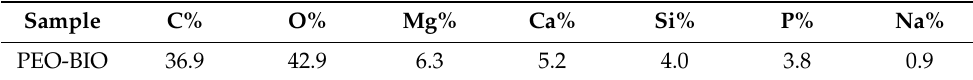
Figure 4. XPS survey scan ( a ) and XPS high-resolution single peak spectra of the Ca2p region ( b ), the P2p region ( c ) and the Si2p region ( d ) for the PEO-BIO sample. Table 2. Surface composition (atomic %) of the PEO-BIO sample, recorded with XPS